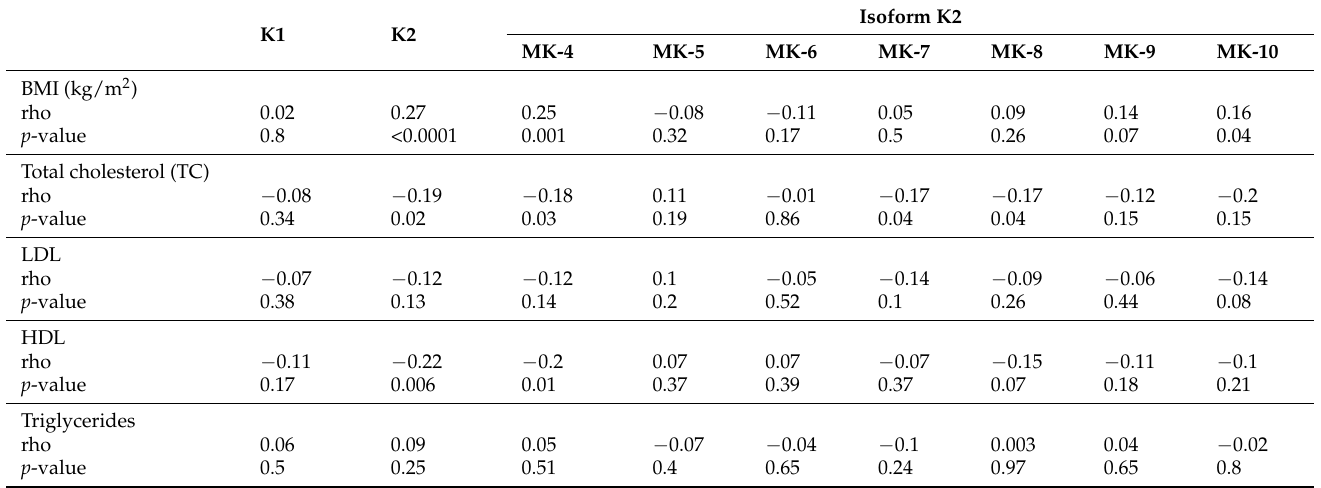
Table 3. Correlation of daily intake of vitamins K1 and K2 and its isoforms MK-4 to MK-10 in relation to selected anthropometric and laboratory